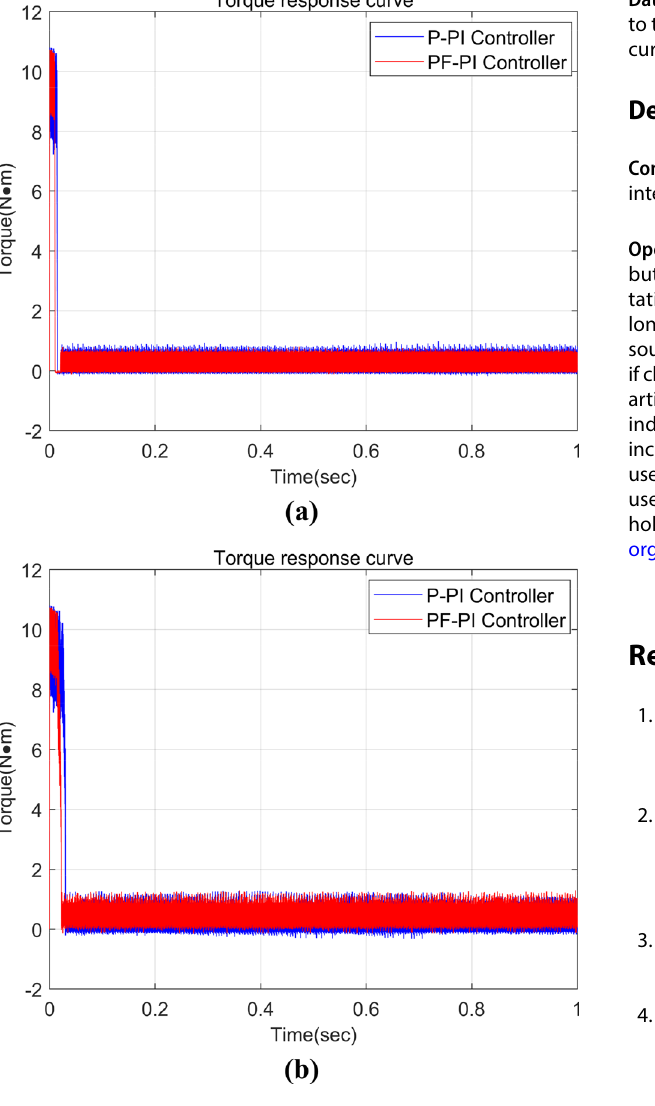
Fig. 19 Torque ripple curves of no-load start under different condi- tions a 0–1500 rpm and b 0–3000